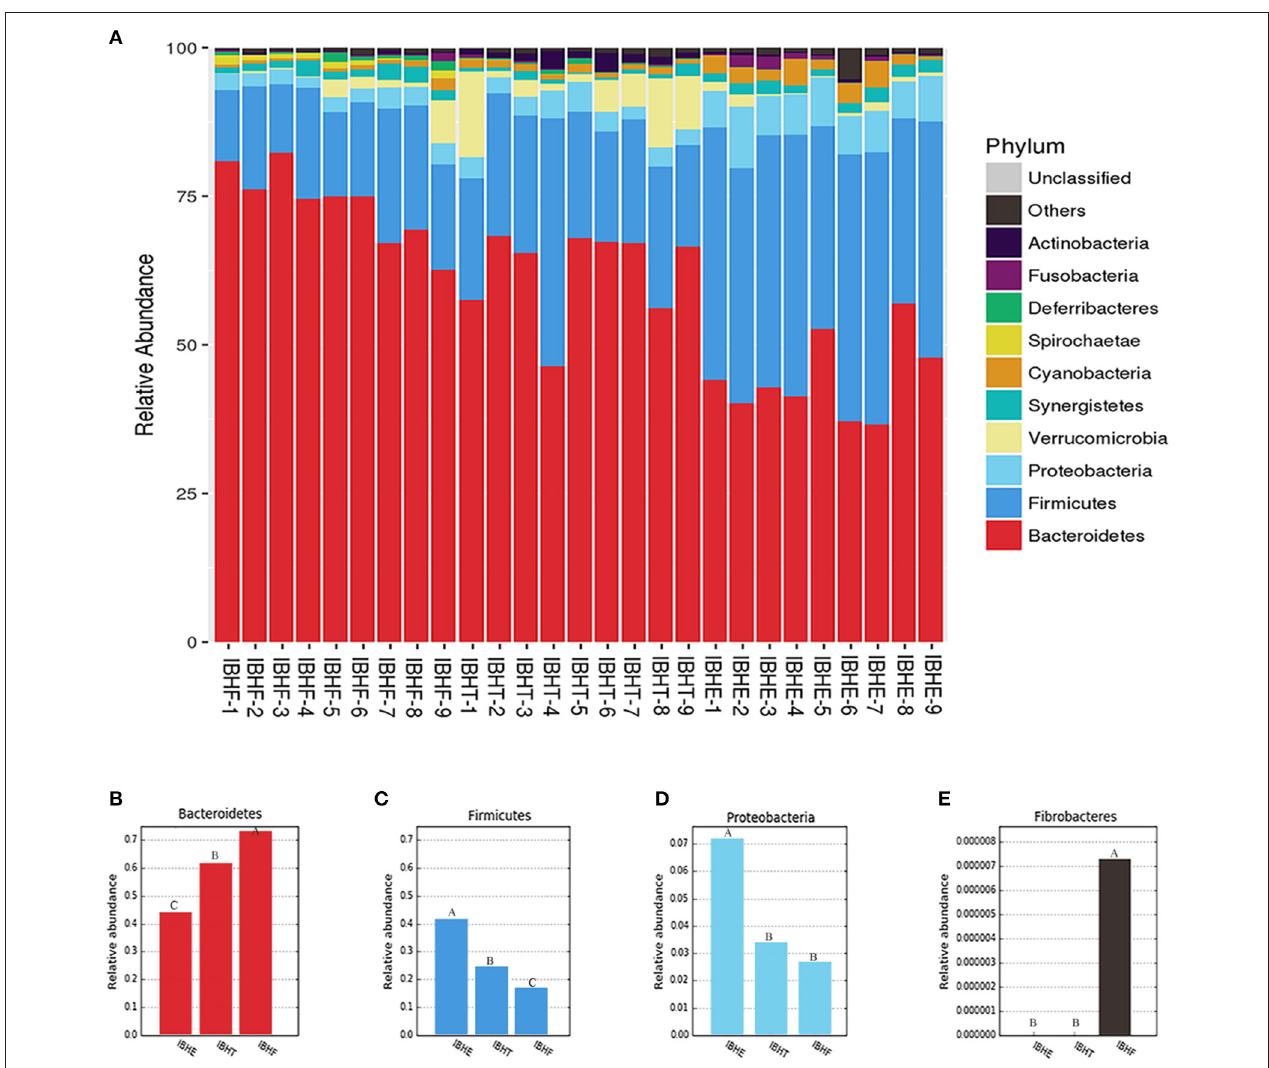
FIGURE 3 | Taxonomy stack distribution and abundance histograms of the dominant bacteria phyla of chickens in different growth periods. (A) Taxonomy stack distribution of the dominant phyla at 8, 20, and 50 weeks. IBHE, IBHT, and IBHF refer to “ISA Brown Hens-8 weeks,” “ISA Brown Hens-20 weeks,” and “ISA Brown Hens-50 weeks,” respectively. The top 10 dominant bacteria during different periods were classified. A distinctive color histogram represents the relative distribution of these most dominant bacteria. The names of distinct levels of phyla are shown on the right of figures, and the names of samples are under the figure. (B–E) Abundance histograms of some significant dominant phyla at 8, 20, and 50 weeks. Phyla with different superscript letters mean significant differences ( P < 0.05) between groups, and different superscript letters mean extremely significant differences ( P <